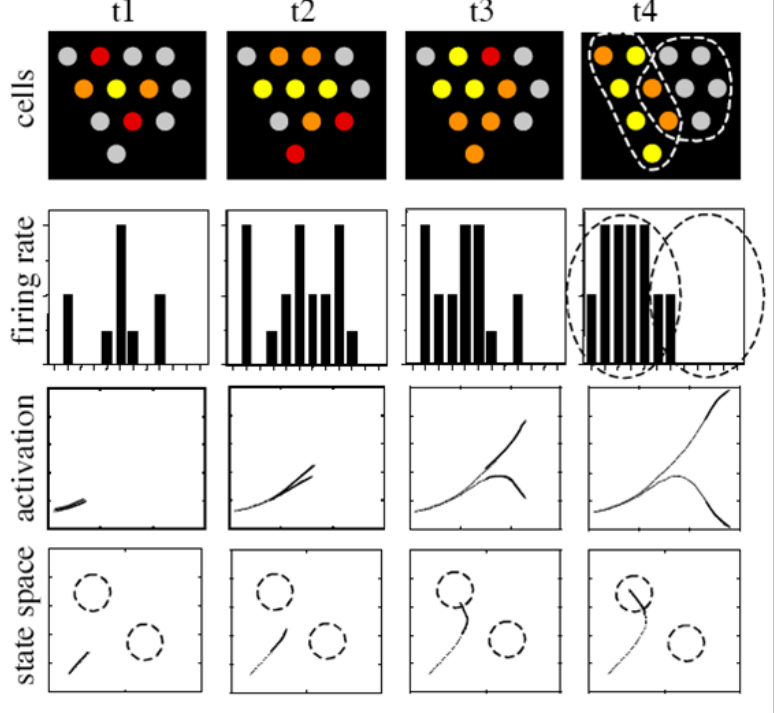
Figure 2. Two population codes (circled with dashed lines in the rightmost top panel) are mutually competing, and one will win. The figure depicts a theoretical mapping of the equivalence, over four 100ms time periods, among a neural population code‘s distributed activity pattern (top row, where red-orange-yellow means greater activity), its cell firing rates (second row), activation of the mental representations that correspond to the two population codes (third row) and the trajectory through state space that settles into one attractor ( i.e. , stable population code) rather than the other. The spike rates of these cells can be treated as coordinates in a 12-dimensional space, of which the bottom row depicts a 2-dimensional compression. During the first time period (column t1), the two partially overlapping groups of cells each have a few of their members somewhat active and spiking (responding to combinations of phonetics, semantics, syntax, etc. ). In the third row, the two representations are slowly emerging during this initial time period (where the activation curves are starting to rise over time). In the fourth row, the state of the system is just beginning to move toward the two attractors (dashed circles) in state space. During the second time period (column t2), both population codes ( i.e. , representations) are continuing to increase in their respective activation patterns, and the trajectory is moving even closer to the two attractors. (Solid portions of a curve/trajectory indicate activity change during that time period, and dashed portions indicate the history of that activity change.) During the third time period (column t3), competition causes the left-hand group of cells to continue increasing its activity while the right-hand group decreases, thus the state-space trajectory begins to move toward one attractor and away from the other. During the fourth time period (column t4), one population code is nearly saturated while the other is nearly silent (dashed circles), its representation has risen to a high level of activation while the other is nearly inactive, and the trajectory has fully entered the perimeter of a particular